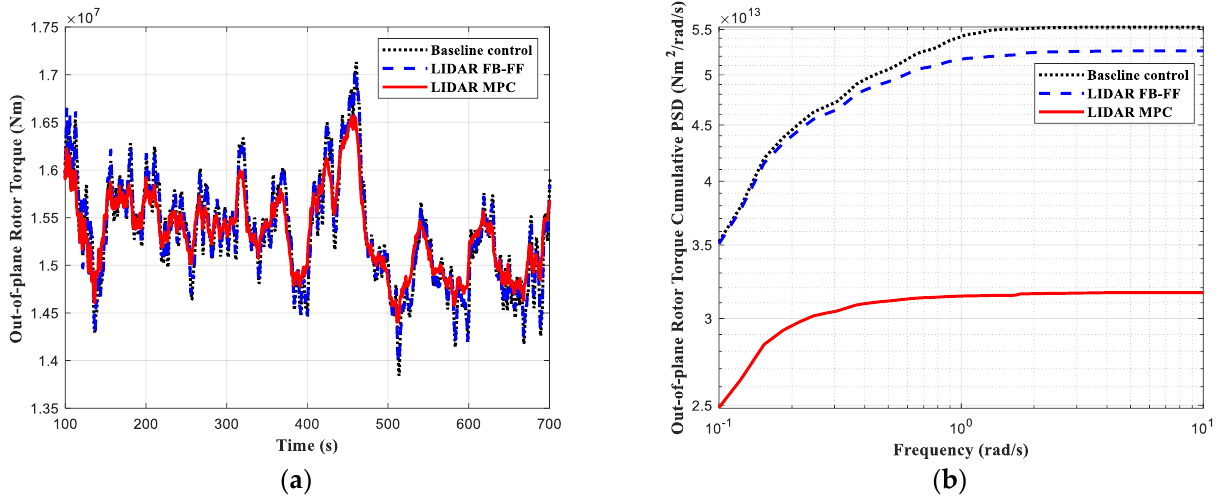
Figure 4. Out-of-plane rotor torque: ( a ) time profiles; ( b ) cumulative PSD (for wind speed with 5% turbulence intensity).